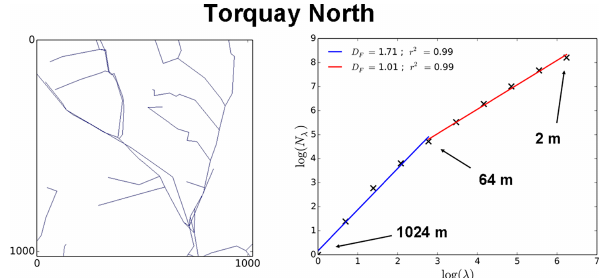
Figure 4. Sewer system (left) and computation of the corresponding fractal dimension, i.e. Eq. (1) in log–log plot (right), for the Torquay north study area. For the left figure, the axes correspond to metres (m).